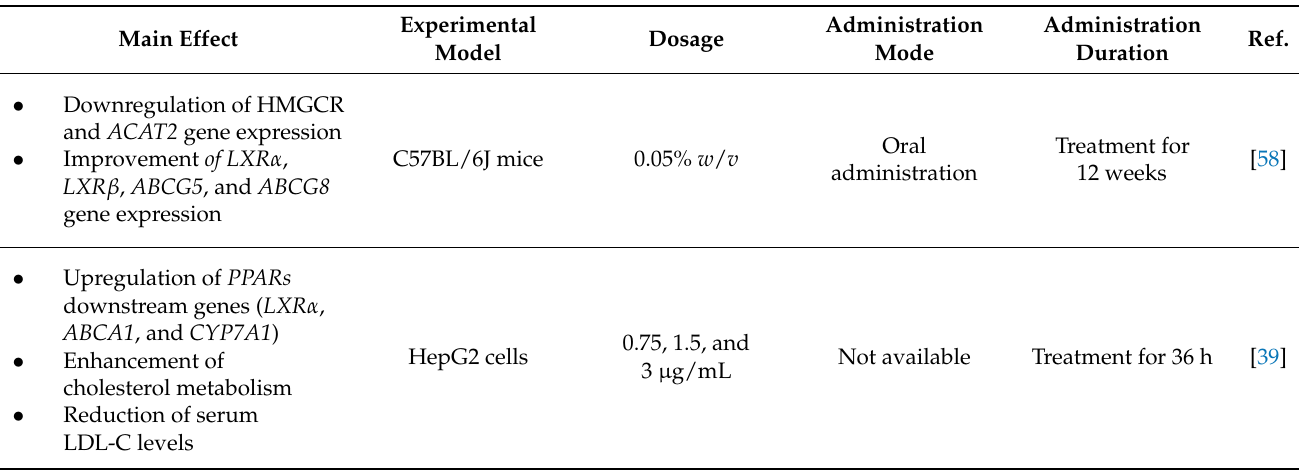
Table 4. The effects of sesamol on cholesterol